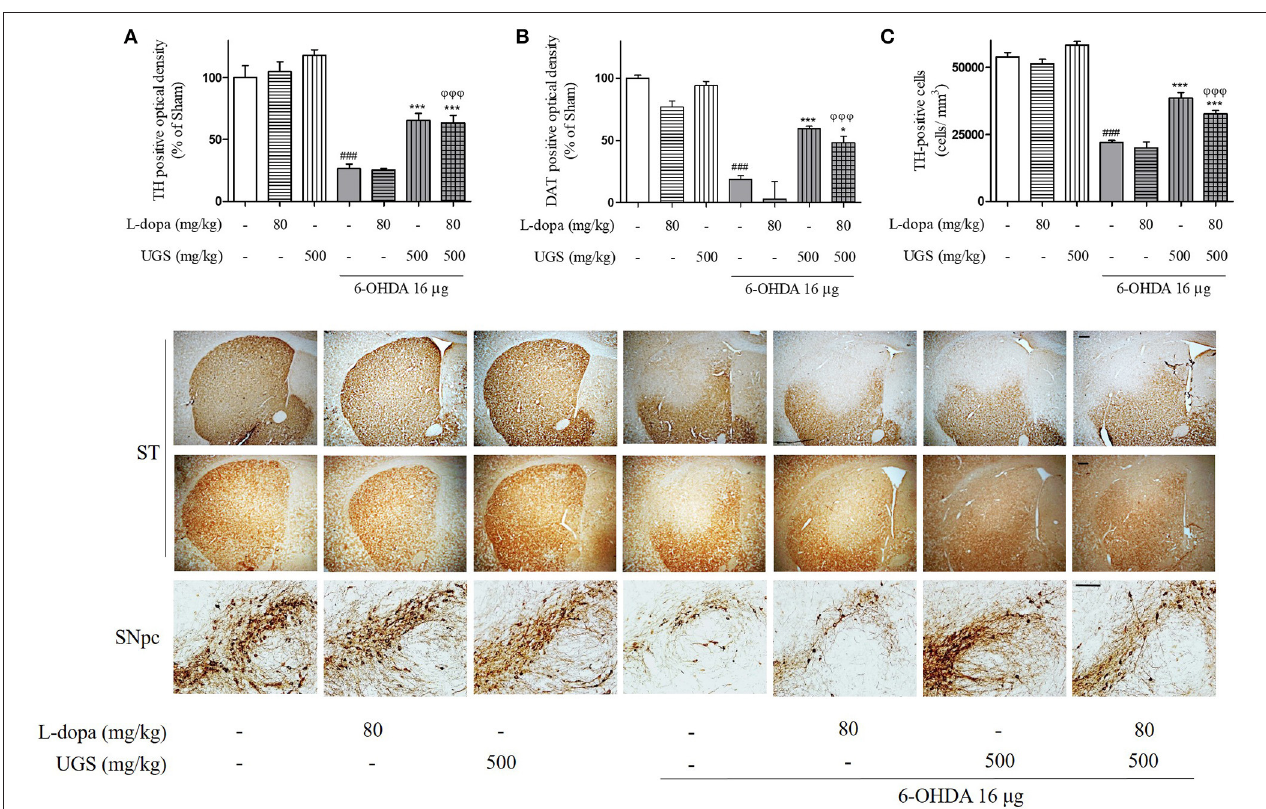
FIGURE 3 | UGS treated with L-dopa reduced the dopaminergic neuronal damage induced by 6-OHDA in the mouse ST and SNpc. To impede the progress of PD, drugs have to restore dopaminergic neurons against toxicity. To evaluate the restorative effect, dopaminergic neurons were visualized with TH and DAT-immunostaining in nigrostriatal pathway. The optical density of TH and DAT-positive fibers in the ST was measured (A,B) . The stereological TH-positive neurons in the SNpc were counted (C) . Scale bar = 100 µ m. Values of quantification data are given as the mean ± S.E.M. ( N = 8). The significance of differences was analyzed by one-way ANOVA followed by Bonferroni’s Multiple Comparison Test: ### p < 0.001; mean values were significantly different from the sham group. * p < 0.05 and *** p < 0.001; mean values were significantly different from the 6-OHDA group. φφφ p < 0.001; mean values were significantly different from the 6-OHDA + L-dopa